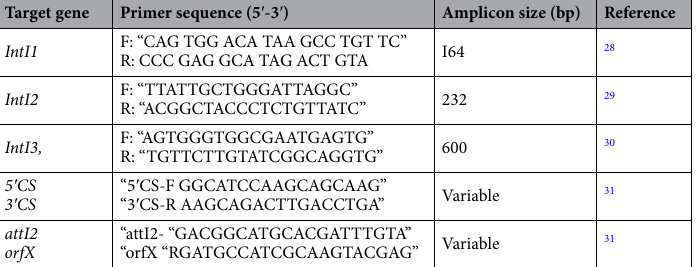
Table 2. List of primers used in this study.